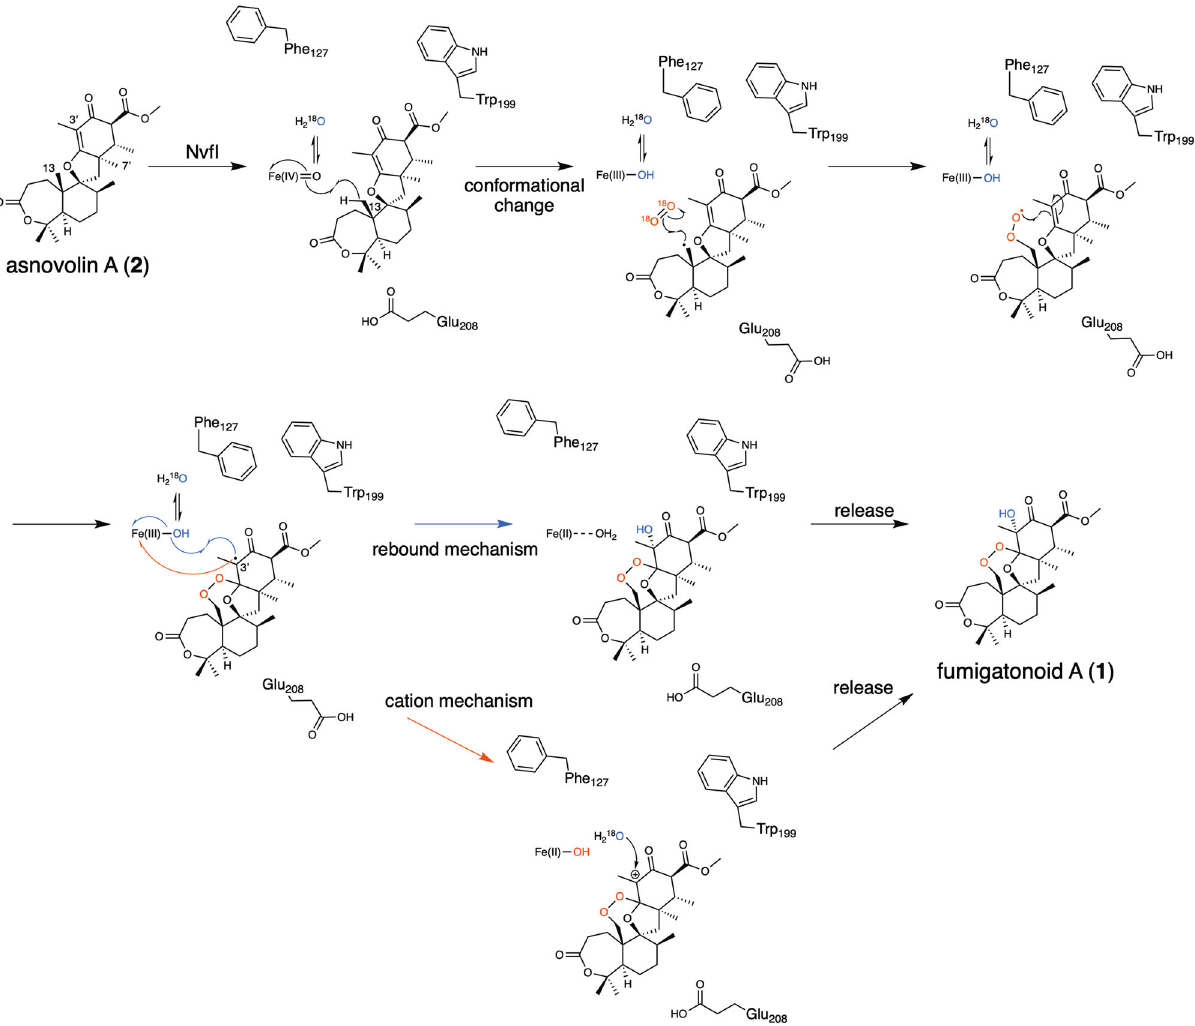
Fig. 7 Proposed mechanism of the NvfI enzymatic reaction. Schematic representation of the proposed mechanism for the NvfI-catalyzed endoperoxide formation